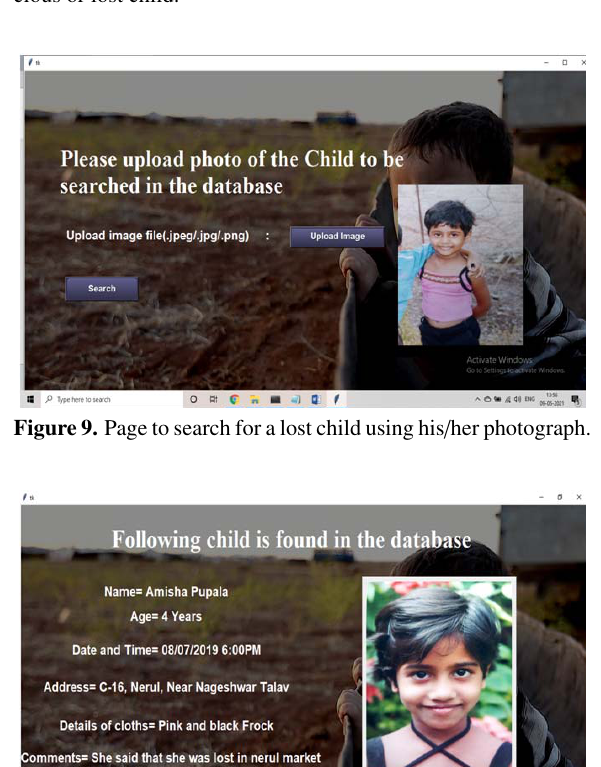
Figure 8. Page where the public can upload details of a suspi- cious or lost child.